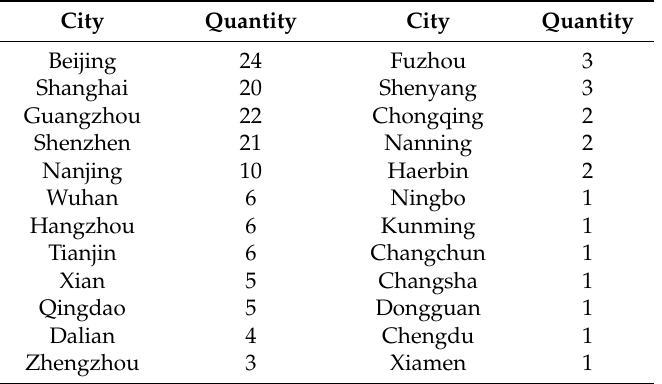
Table 2. Quantity of accident reports in urban rail transit (URT) construction. City